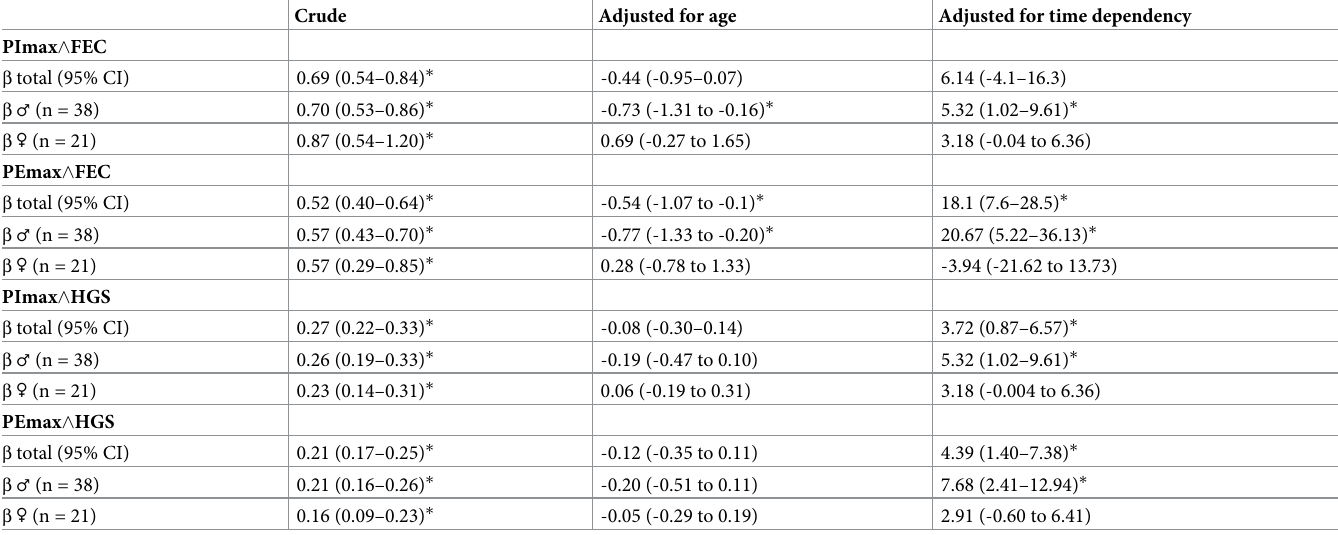
Table 4. Longitudinal associations between respiratory muscle weakness and functional outcomes, stratified by